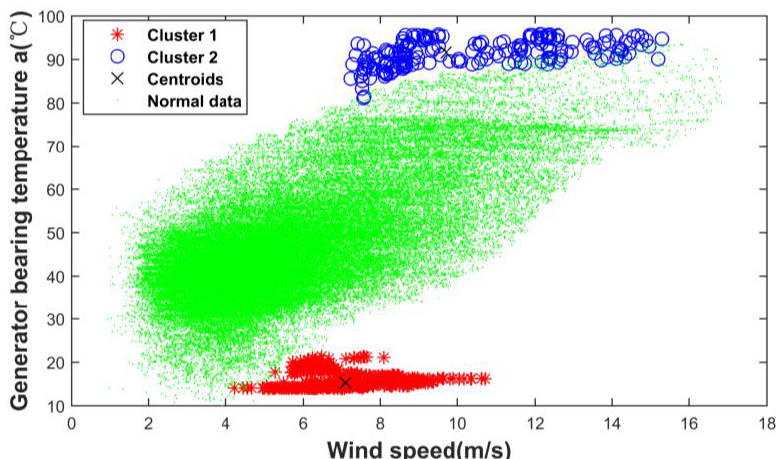
Figure 6. Characteristic quantity “wind speed vs. generator bearing temperature a”.